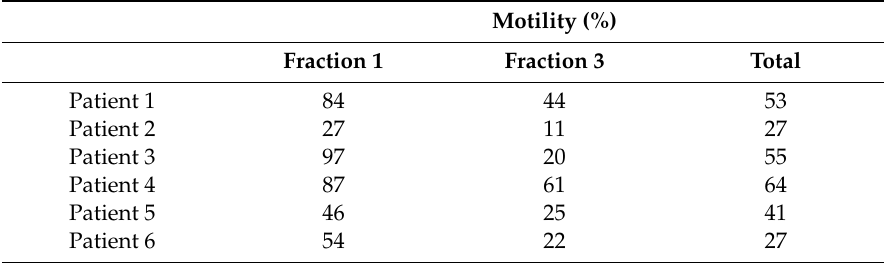
Table 1. Motility of spermatozoa belonging to the single fractions. Fraction 1 represents the capacitated sample, while fraction 3 accounts for the pellet one. The total is the initial